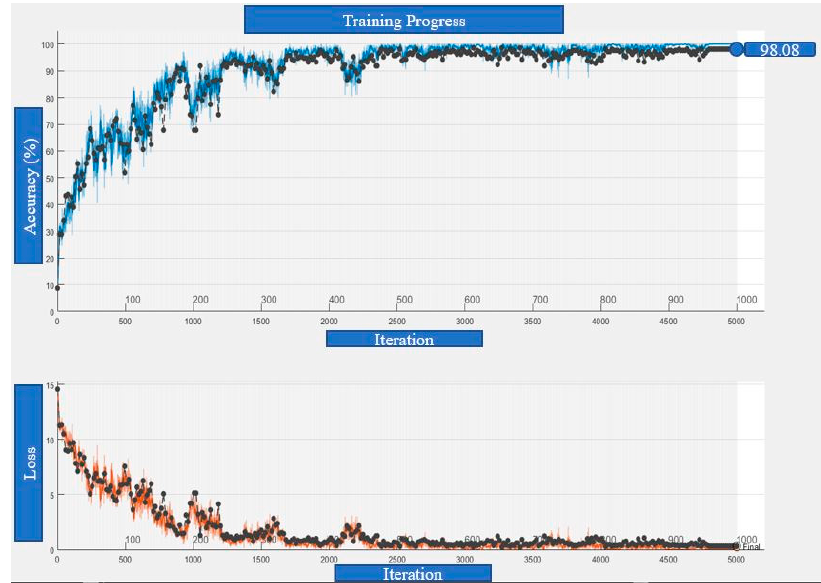
Figure 10. GoogLeNet training procedure: accuracy; loss.